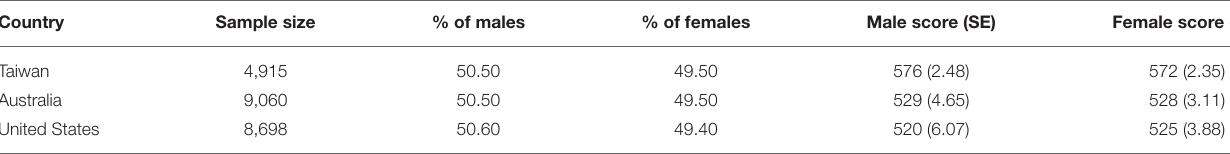
TABLE 1 | Sample size, percentage of sample size, and science scores by gender in three countries.